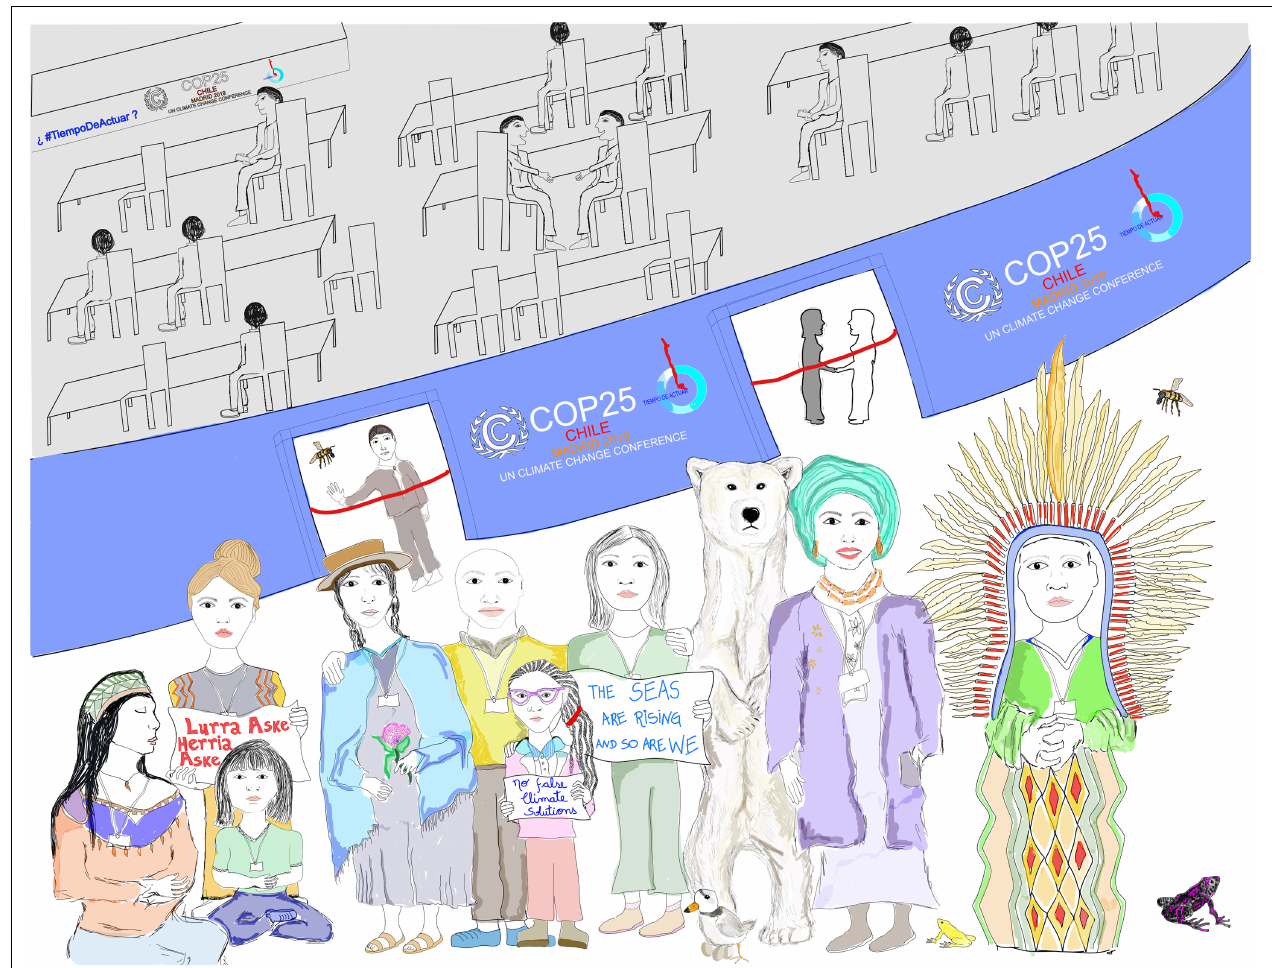
FIGURE 1 | The two realities of the Conference of Parties 25 (COP 25) inside the Baker Hall at Feria de Madrid, Spain. In the main plenary room, high-level negotiations/meetings are held. Outside, Observers gather to make their voices heard, including representatives from Indigenous communities, youth organizations, the Women and Gender Constituency among many others. COP participants frequently wear clothes or hold up signs that reflect their identity and core values. Animals are also depicted here since they are indirectly represented at COP by various observer organizations. Original artwork by author Leticia